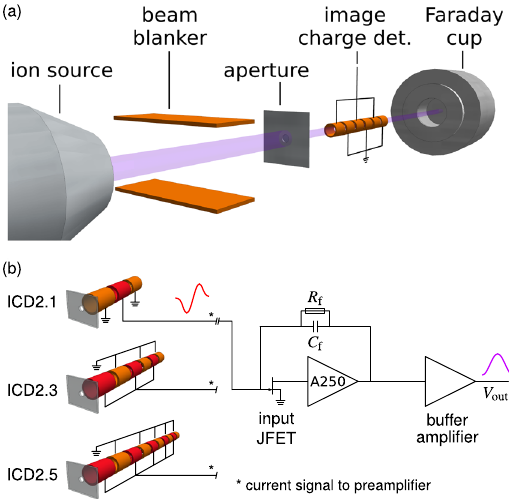
Figure 2. (a) Schematic of the experimental set-up to investigate image charge signals induced by low energy ion bunches. (b) Schematic depiction of the three different detector configurations used, ICD2.1, ICD2.3, ICD2.5, with one, three and five signal electrodes (marked in red), respectively. Exemplary, the transformation of the current signal (red) from detector version ICD2.1 into V out through the A250CF preamplifier electronics is shown 31